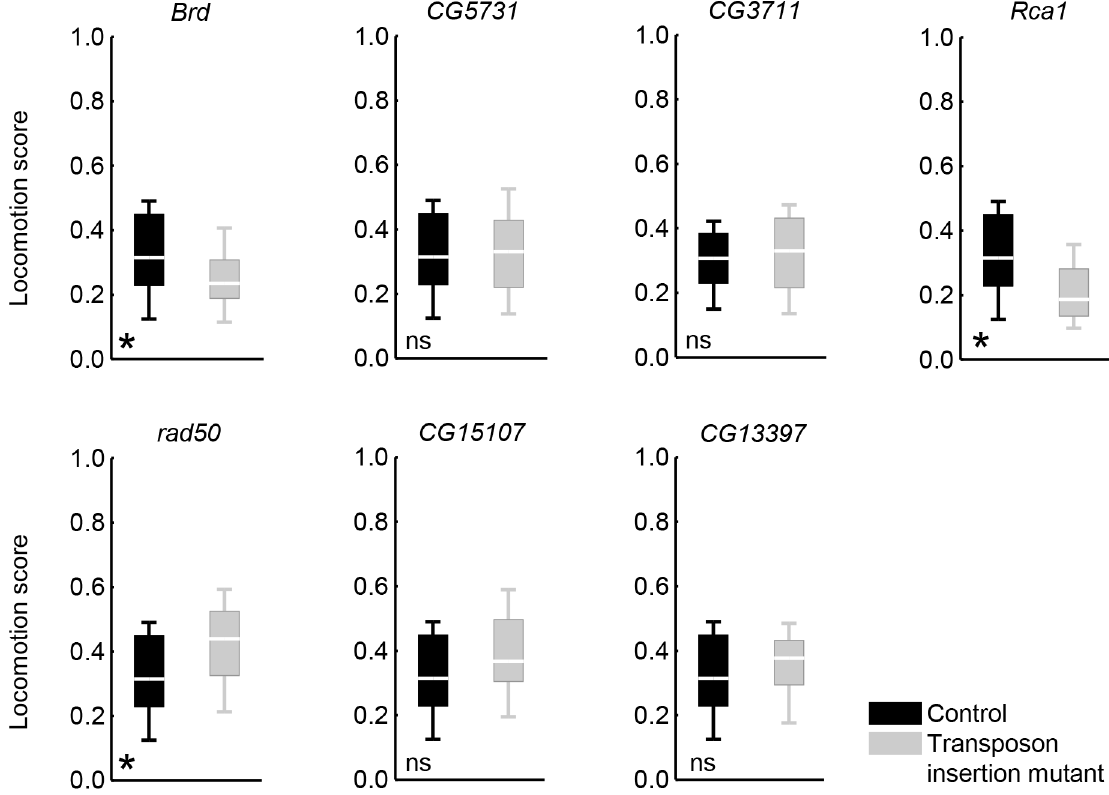
Fig 6. Effects of validated shock avoidance candidate genes on locomotion. Each panel shows, for the indicated gene, the locomotion scores of a respective transposon insertion mutant vs . those of the corresponding control. Please note that the genotypes are identical to those used in the respective panels of Fig 4 (see S7 Table for full genotypes). We used a locomotion assay that mimicked the shock avoidance assay except for the presentation of shock. Thus, using the setup and temporal schedule depicted in Fig 1A, at 6:00 min, instead of delivering shock pulses, the setup was vigorously shaken to force flies to the end of one maze-arm. The setup was then immediately put back to its horizontal position, letting the flies disperse towards the opposite arm in the absence of shock. The maze was sealed 25 s later and the locomotion score was calculated to reflect the ratio of flies that had travelled more than a shock tube-length in the given time. In 3 out of 7 cases, locomotion scores significantly differed between the genotypes. * : FDR < 0.05, ns: FDR (cid:1) 0.05. Sample sizes are given in S7 Table. Box plots are as explained in Fig